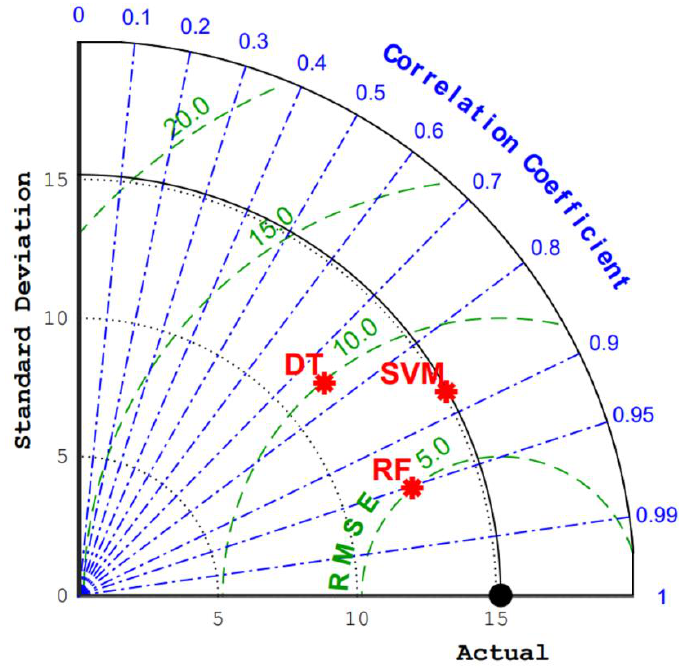
Figure 8. Taylor diagrams of test sets for different models.